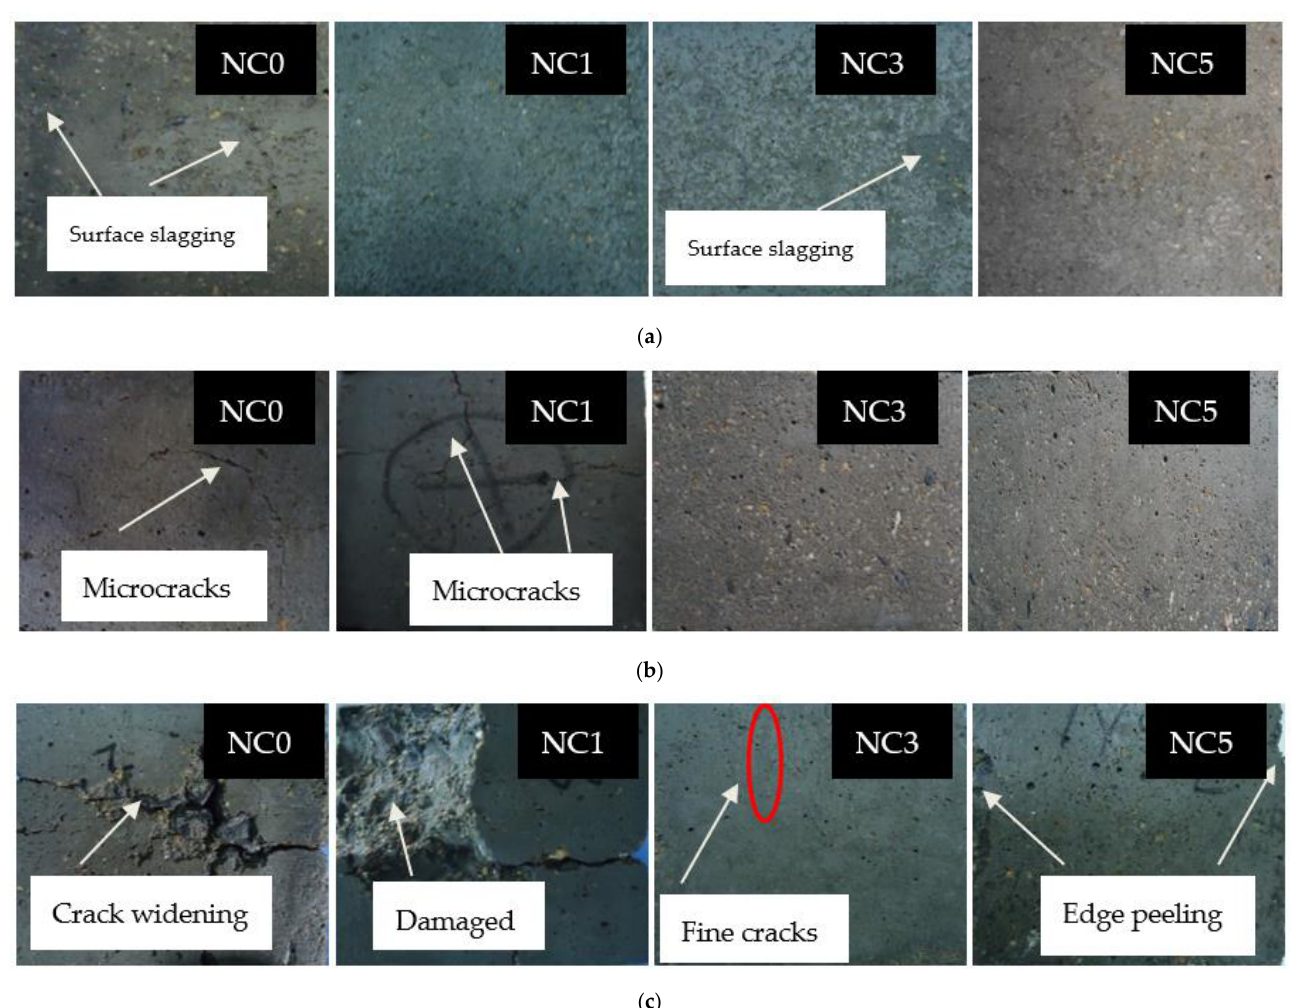
Figure 5. Micro-crack extension on the surface of concrete at various freeze-thaw cycles.(a) Freezing thaw cycles: 50; (b) Freezing thaw cycles: 75; (c) Freezing thaw cycles: 100.